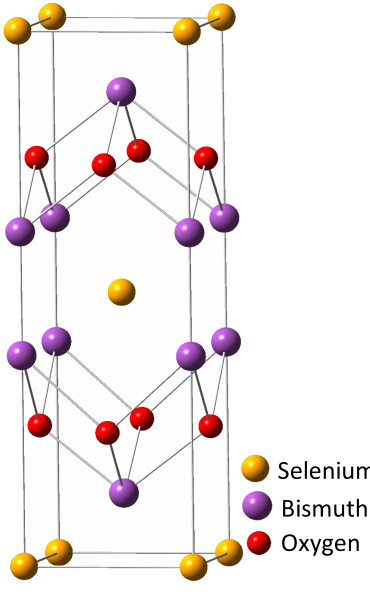
Figure 3: Crystal structure of Bi 2 O 2 Se.